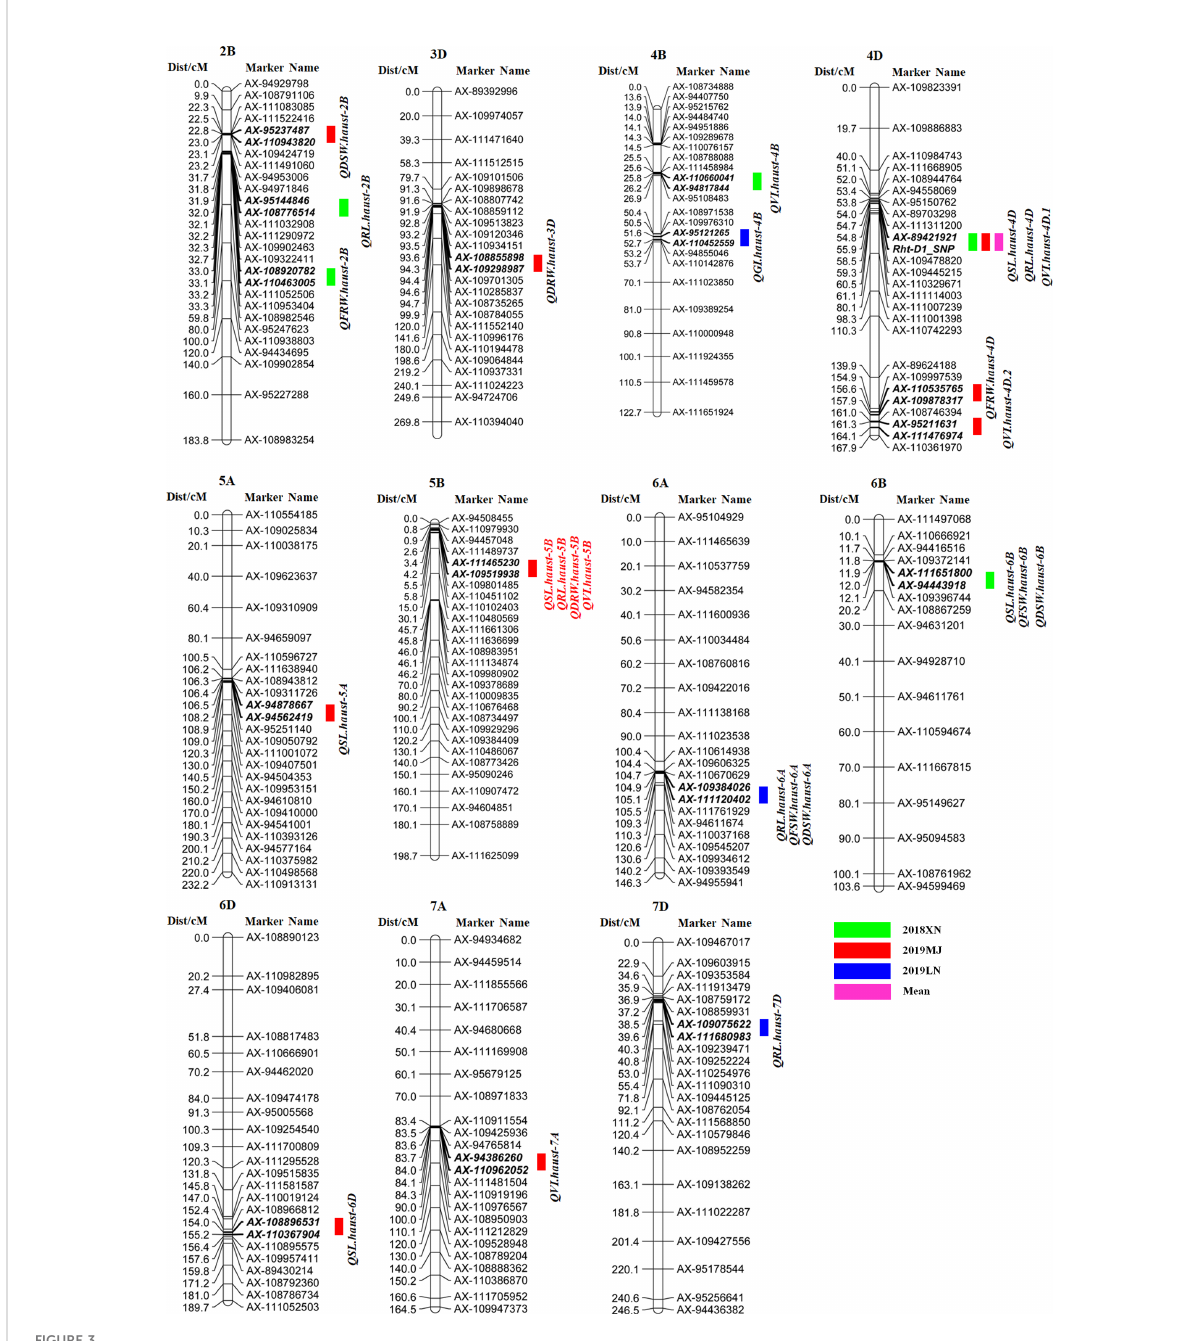
FIGURE 3 QTL mapping for seed vigor related traits in the Yangmai 16/Zhongmai 895 DH population. Markers ’ names are shown on the right of vertical axis, and their genetic positions are shown in cM on the left. Green, red, blue and purple represent QTL mapped using data of 2018XN, 2019MJ, 2019LN and mean values,